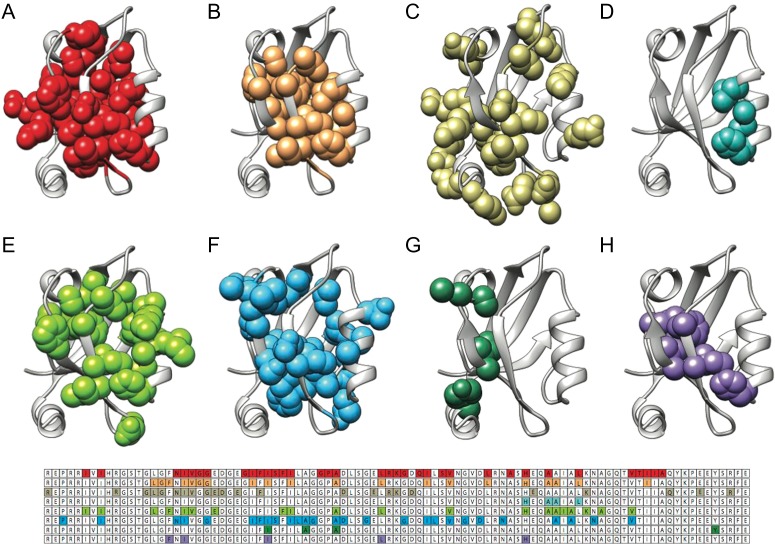
Allosteric networks in PSD-95 PDZ3 determined by different approaches. Allosteric networks mapped in human PSD-95 PDZ3(pdb 1be9) with different methods: (A) Perturbation response scanning (PRS; Gerek and Ozkan, 2011) (B) Statistical coupling analysis (SCA) (McLaughlin et al., 2012) (C) Molecular dynamics simulation (Kumawat and Chakrabarty, 2017) (D) Deep coupling scan (DCS) (Salinas and Ranganathan, 2018) (E) Thermodynamic double mutant cycle (TDMC) (Gianni et al., 2011) (F) Conservation mutation correlation analysis (CMCA) (Du et al., 2010) (G) Rigid-residue scan (RRS; Kalescky et al., 2015) (H) Monte Carlo path (MCPath; Kaya et al., 2013).